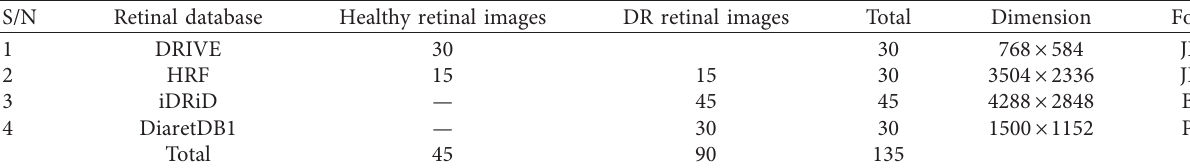
Table 1: Summary of retinal images